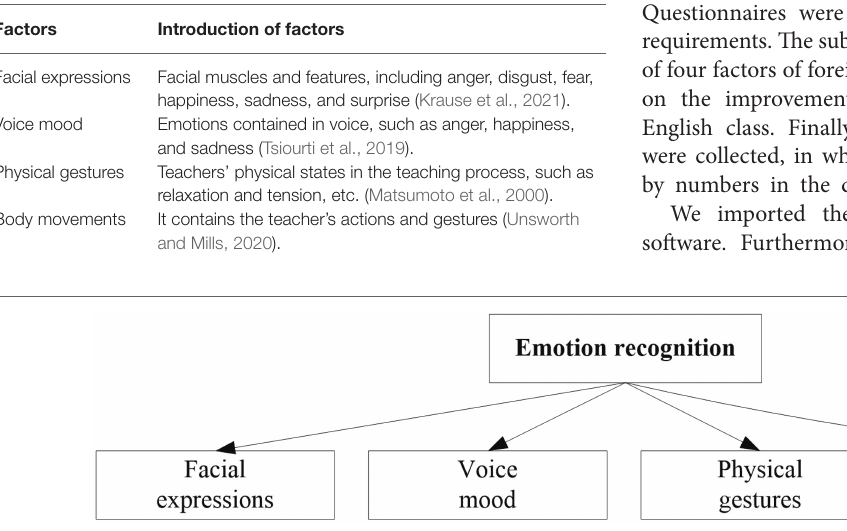
TABLE 1 | Factors of foreign language teachers’ emotion recognition.